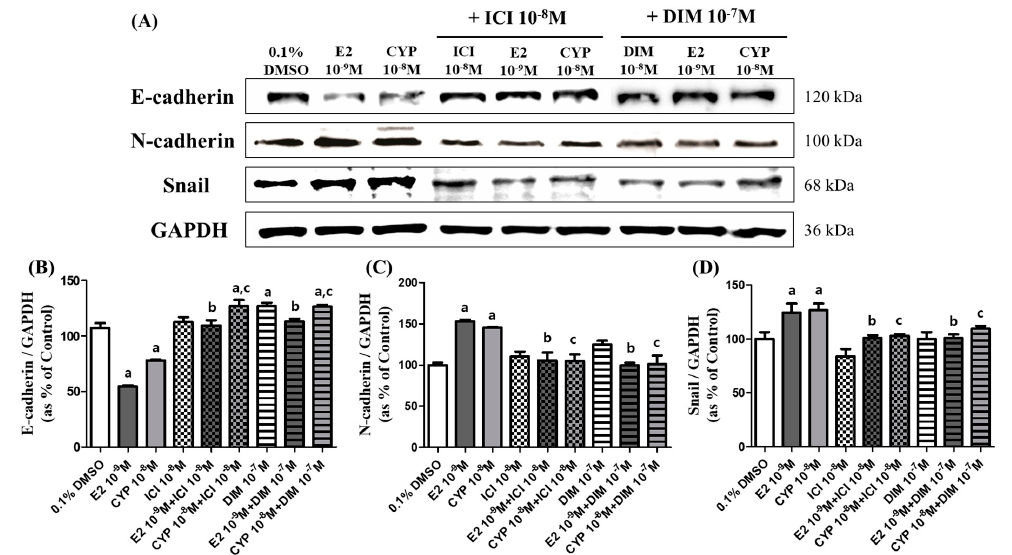
Figure 3. Effects of E2, CYP, ICI 182,780, and DIM on the expression of EMT related genes. Ishikawa cells were treated with 0.1% DMSO, E2 (10 − 9 M), CYP (10 − 8 M), a mixture of E2 (10 − 9 M) or CYP (10 − 8 M) and ICI (10 − 8 M), or a mixture of E2 (10 − 9 M) or CYP (10 − 8 M) and DIM (10 − 7 M), respectively, for 72 h. Total proteins were extracted and analyzed by Western blot. ( A ) Band images correspond to E-cadherin, N-cadherin, and Snail proteins. Quantification of bands corresponding to ( B ) E-cadherin, ( C ) N-cadherin, and ( D ) Snail proteins was conducted using Luminograph II. The experiment was